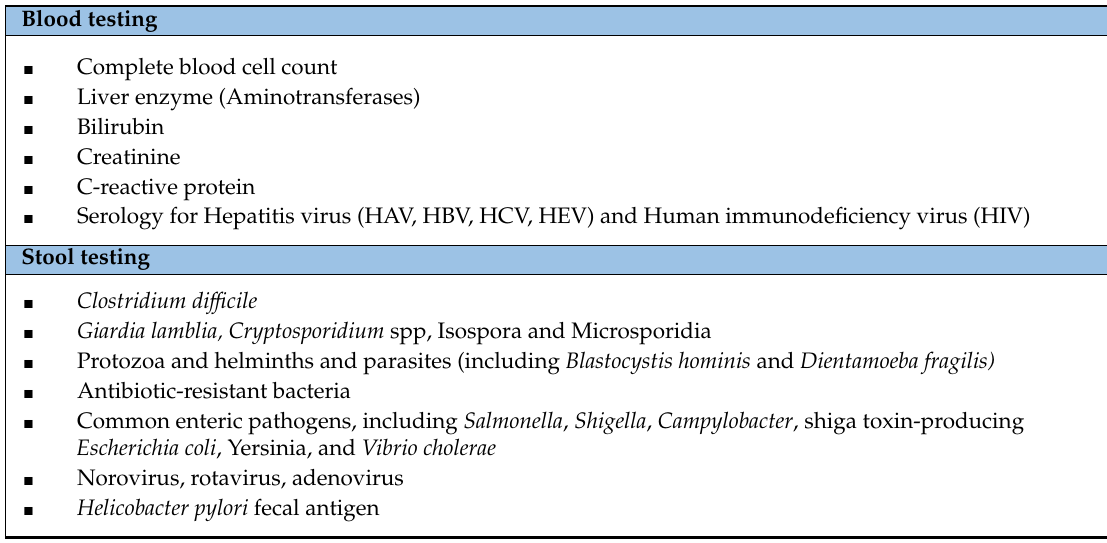
Table 2. Donor blood and stool